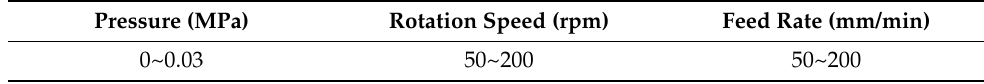
Table 4. Optimization range of processing parameters.